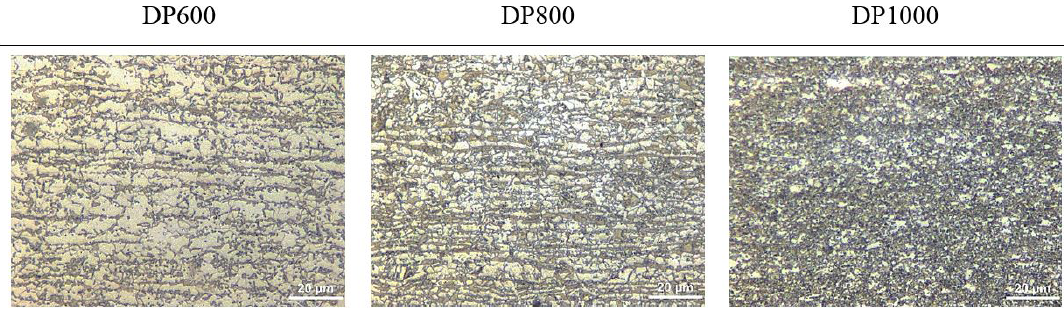
Figure 1. Microstructure images of DP600, DP800 and DP1000 Table 1. Chemical composition of DP600, DP800 and DP1000 steel (wt %) 3 Steel